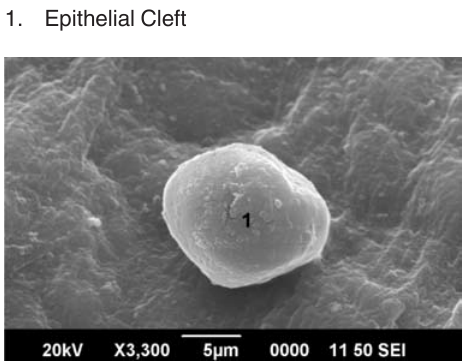
Fig. 3. sEm image of germ cells. sEm x 3300 1. Germ